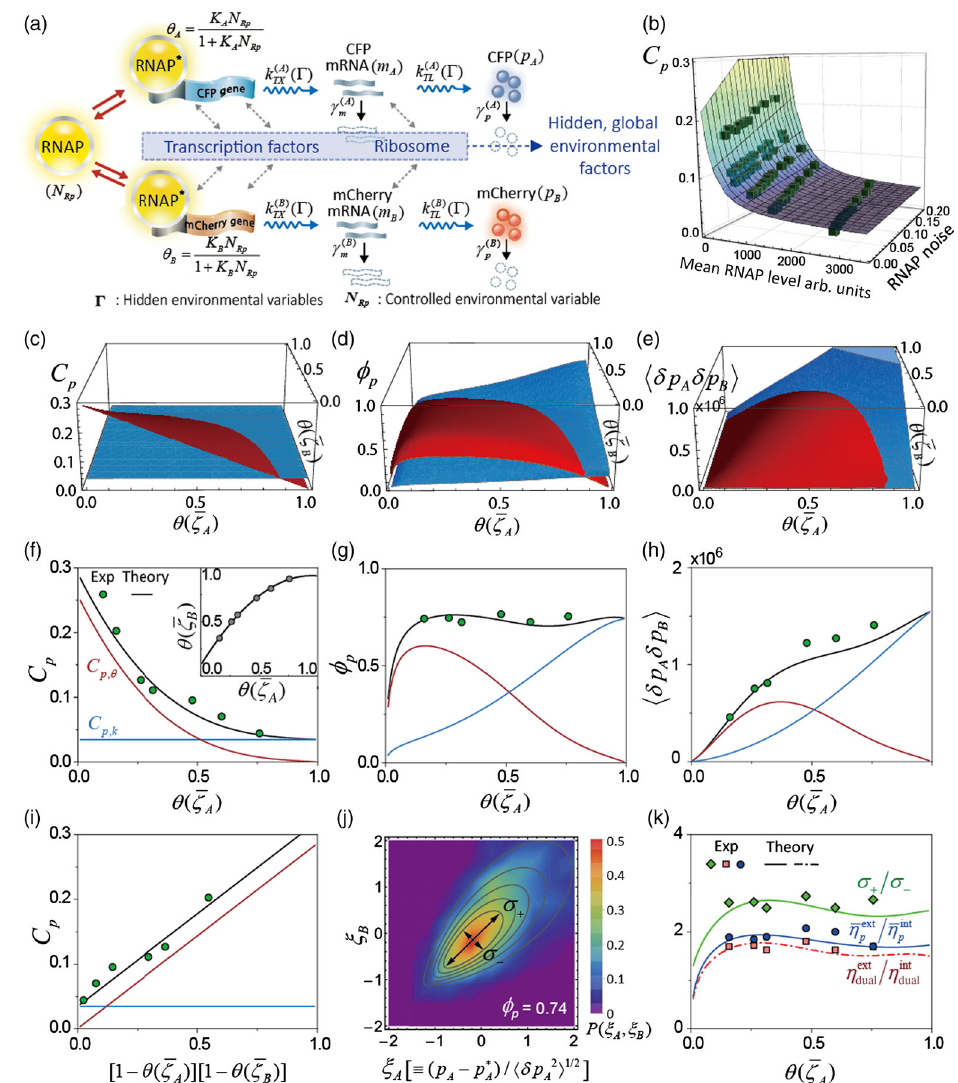
FIG. 6. Quantitative analysis of the environment-induced correlation between the expression levels of dual reporter genes. (a) Our gene expression network model for the dual reporter system expressing gene A ( CFP ) and gene B ( mCherry ). (b) The best global fit of Eq. (10) with Eq. (11) to the experimental data for the dependence of the mean scaled correlation on the mean RNAP level and RNAP noise. See Eq. (I3) for the expression of Eq. (10) in terms of the control variables in the experiment. (c) – (e) The ≡ h δ p δ p = ðh p p environment-induced correlation between the CFP ð p and mCherry ð p levels measured by C , ffiffiffiffiffiffiffiffiffiffiffiffiffiffiffiffiffiffiffiffiffiffiffi p A Þ B Þ p ½ A B i A ih B iÞ(cid:2) ϕ ≡ h δ p δ p = h δ p 2 ih δ p 2 i Þ , and h δ p A δ p B i . They have two components: one originating from the correlated fluctuations of p ð A B i B A θ and θ (red surface) and the other from the correlated fluctuation of k ð A Þ and k ð B Þ (blue surface). (f) – (h) Dependence of C , ϕ , A B p p TX ð TL Þ TX ð TL Þ ¯ ζ ¯ ζ ¯ ζ δ p and h δ p on θ ð . In our system, θ ð is dependent on θ ð , as shown in the inset of (f). They are not the same because the A B i A Þ B Þ A Þ ¯ K ¯ K value of is different from that of (Table I). The red (blue) line represents the contribution of the red (blue) surface in (c) – (e). A B In (f), the theory curve represents the best fit of Eq. (10) to experimental data. In (g) and (h), the theory curves represent the prediction of Eqs. (6), (7), and (10) with predetermined parameter values in Table I. (i) C linearly increases with the probability that both promoters p of CFP and mCherry are unoccupied by RNAP. (j) The joint distribution of CFP and mCherry levels represented by heat map (experiment) and the contour plot (joint gamma distribution). See Fig. 16 of Supplemental Material [32] and Appendix K for more ; p ∗ details. Near the most probable protein level, ð p ∗ Þ , the joint distribution becomes the two-dimensional Gaussian (Note 8 in B A ( σ − ) along the positive (negative) diagonal direction. and Fig. 17 in Supplemental Material [32]) with standard deviation σ þ ¯ ζ ≥ η ext = σ − , η ext = η int = ¯ η int = σ − > ¯ η ext = ¯ η int = η int (k) Dependence of σ , and ¯ η ext on θ ð . σ . The value of the RNAP noise η 2 is the p p p p A Þ þ þ N Rp dual dual dual dual same as in Figs. 3(d) and